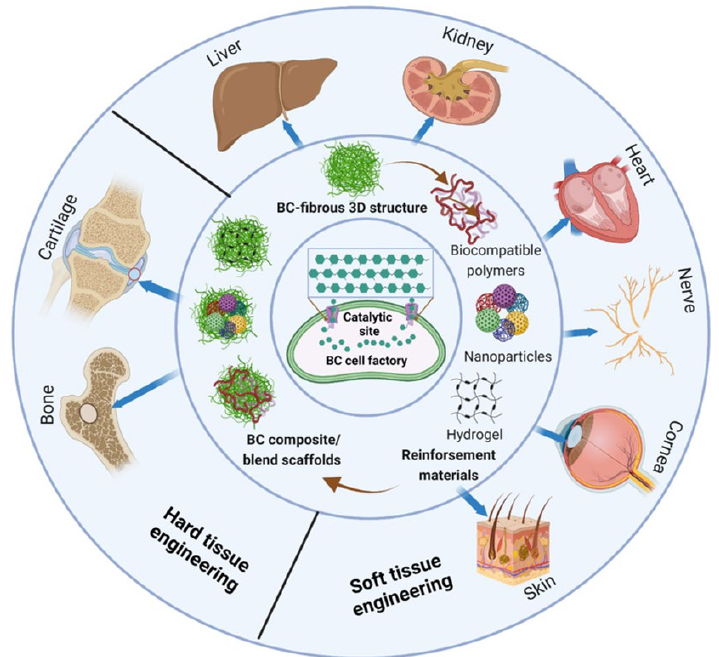
Figure 1. Schematic illustration of the application of BC-based composite/blend scaffolds in various regenerative tissue engineering (Created with BioRender.com; accessed on 28 November 2022).